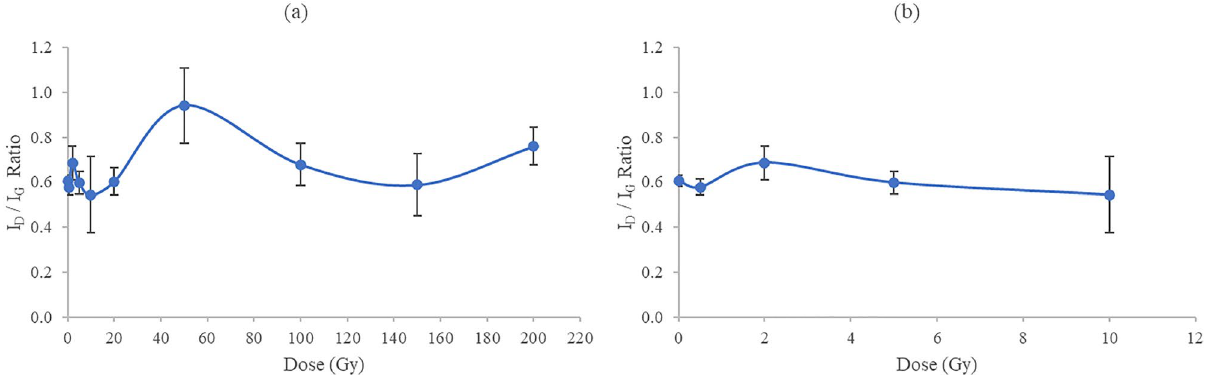
60 Co γ -rays, irradiation dose